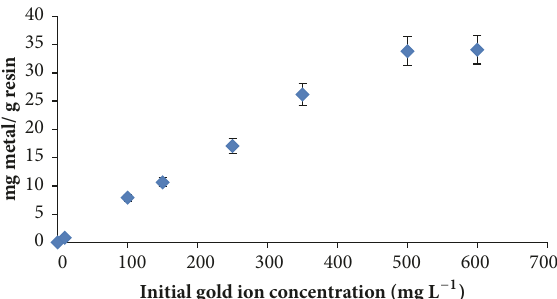
Figure 3: Gold ion capacity of resin. Amount of resin: 0.1 g, amount of DEBT: 1 mmol g −1 resin, and stirring time: 15 minutes.